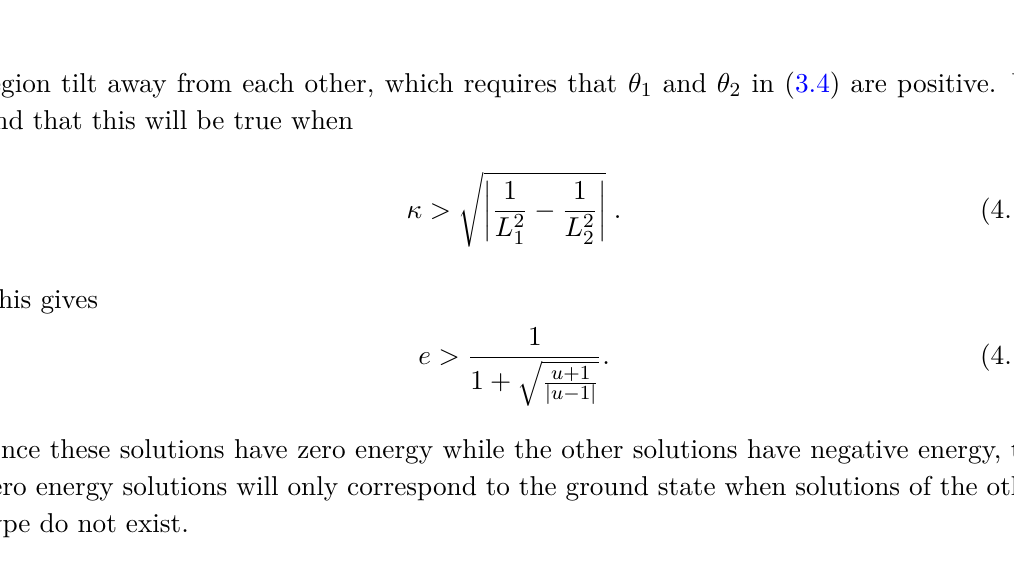
Figure 5. Alternative solutions with zero vacuum energy. The two regions are joined along the domain walls as